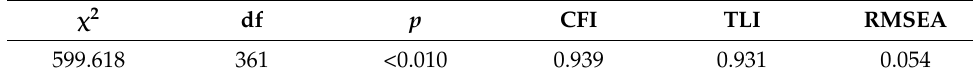
Table 6. Structural equation model